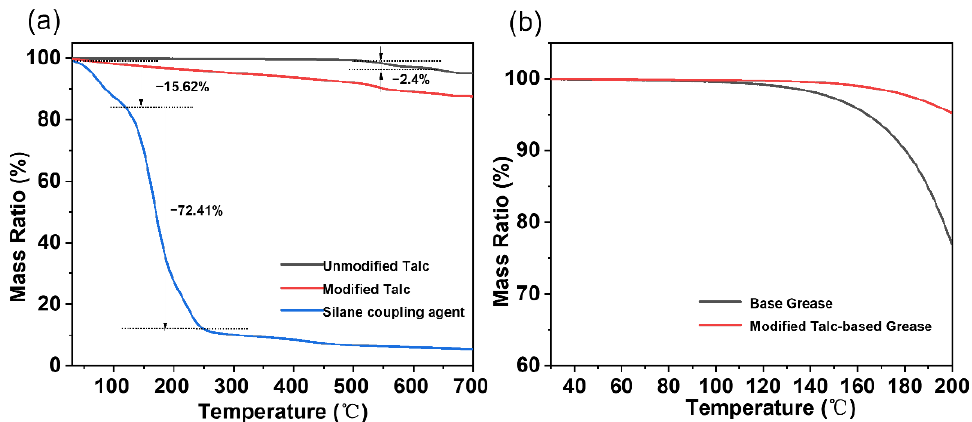
Figure 4. FTIR analysis of the modified talc nanosheet.